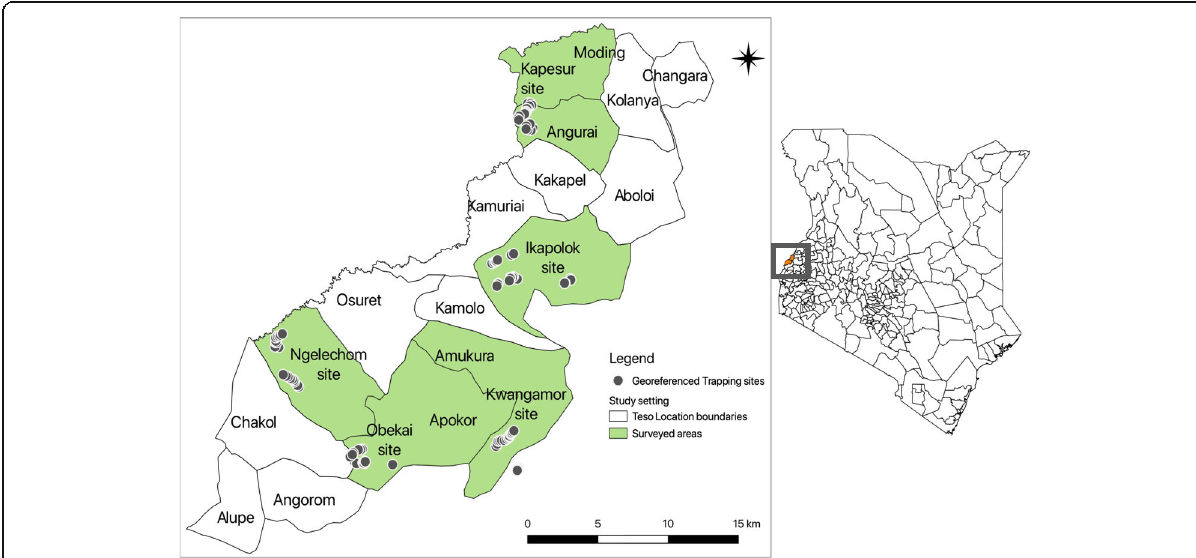
Fig. 1 Map showing the study area and location of study sub-counties, and the selected sites for tsetse trapping. Dots represent the location of individual traps. The shaded area under the map shows the trapping